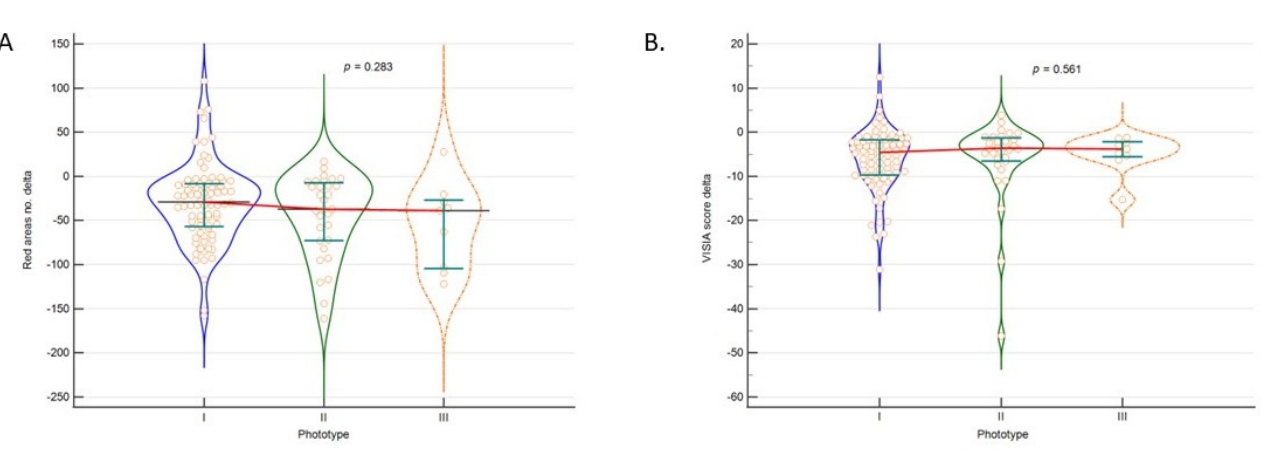
Table 2. Correlation analysis between studied parameters and number of laser procedures and age of persons regarding sex. Whole Group